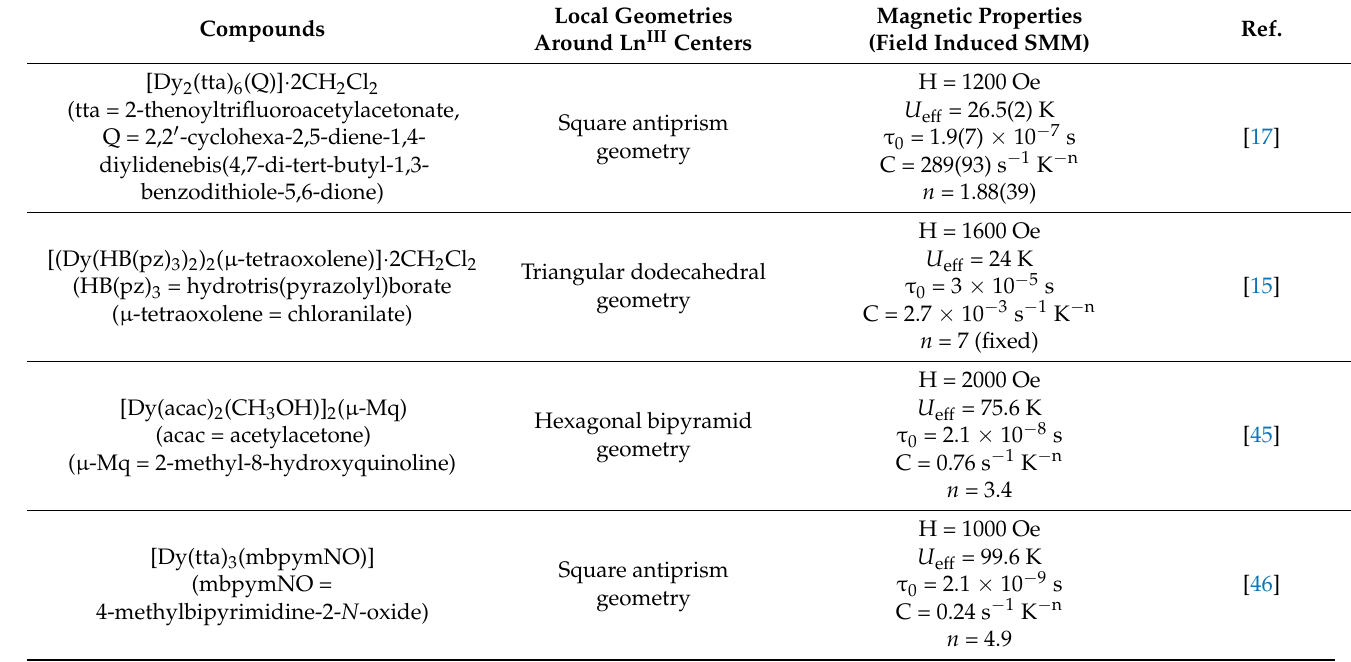
Figure 6. Temperature variation of the relaxation time for 2 for high frequency (gray spots) and low frequency (black spots) contributions in the temperature range of 2–9 K with the best fitted curves with Raman processes (red lines) (see text for details). Table 1. Examples of dysprosium SMMs relaxing through Raman